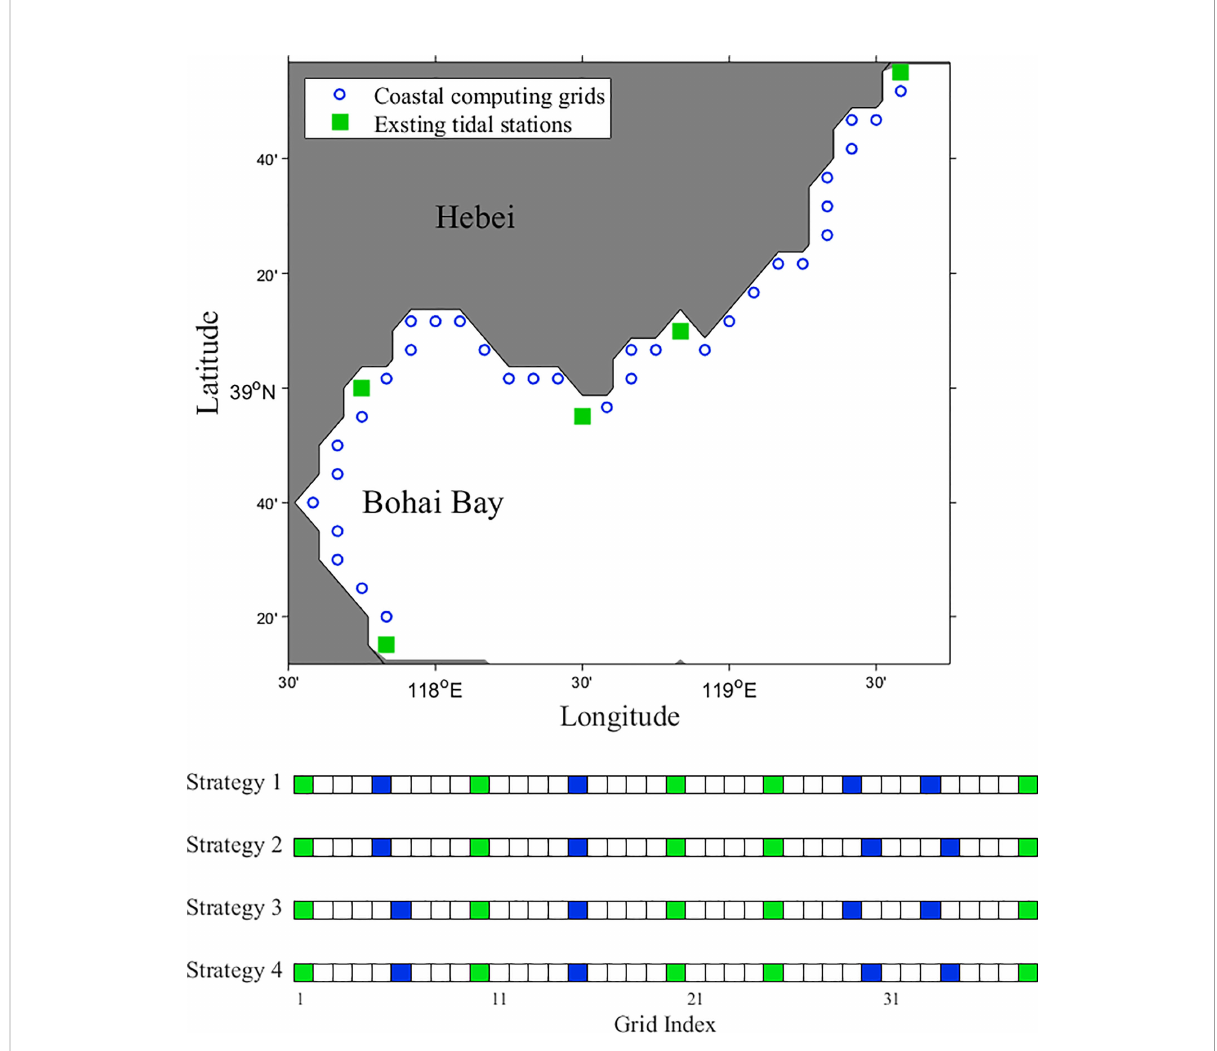
FIGURE 7 The map of subdomain in the west of the Bohai Sea and four different siting strategies in the form of grid (the green grids represent existing tidal stations and the blue grids represent new tidal